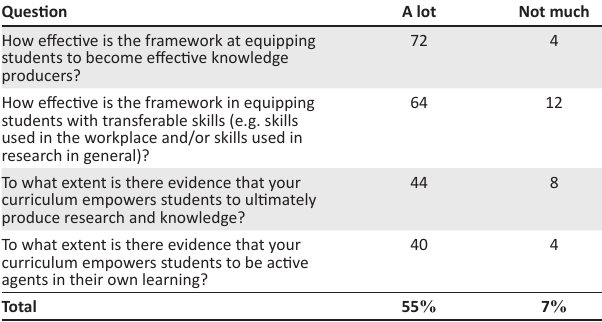
TABLE 1: Perceptions on empowering students.